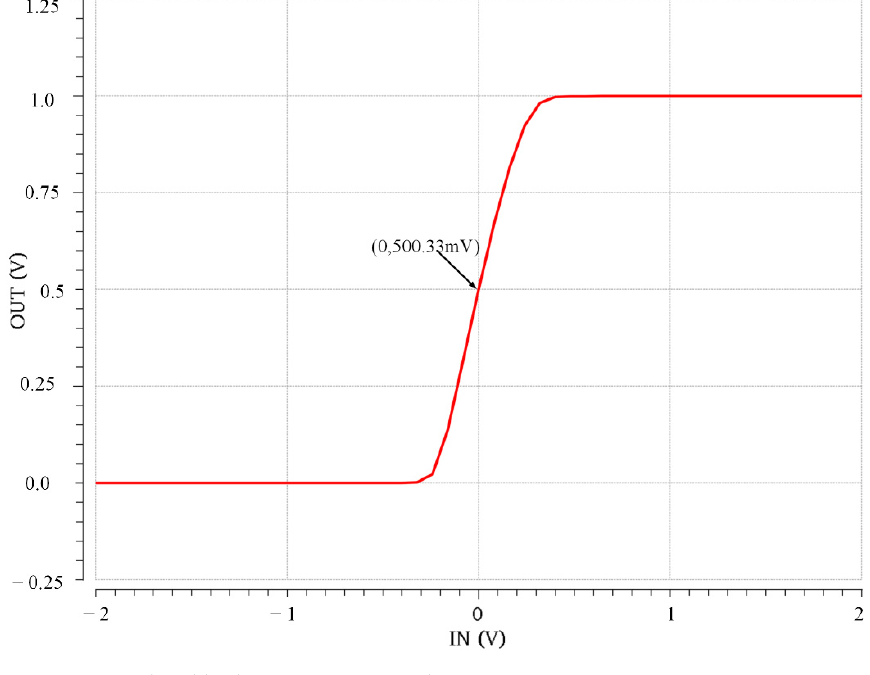
of M4. The slope of L (cid:3013)